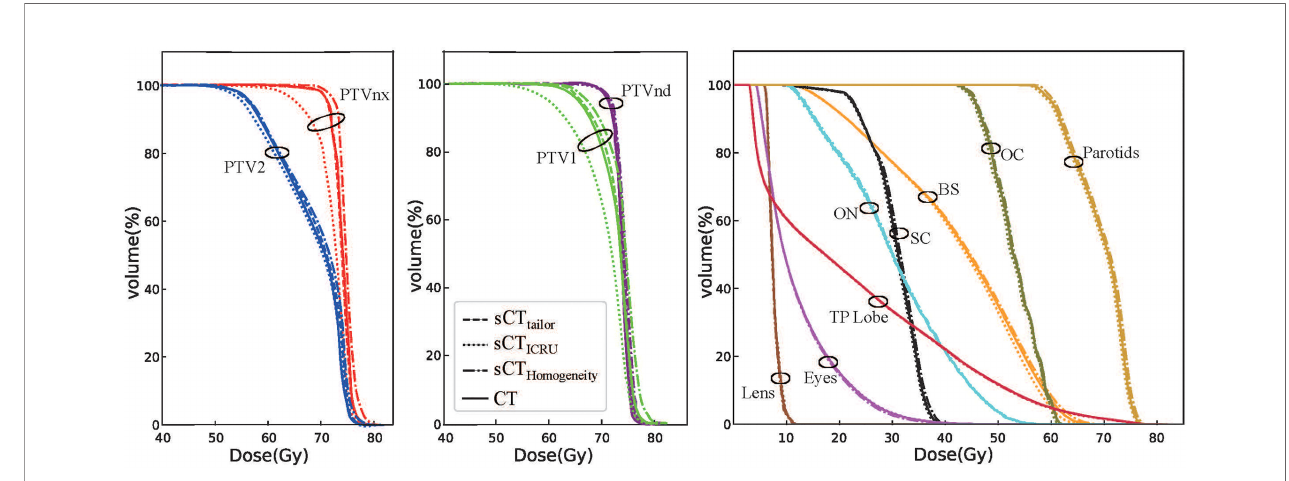
FIGURE 5 | DVH comparison of plans on sCT tailor , sCT ICRU , and sCT Homogeneity with respect to the original CT for one